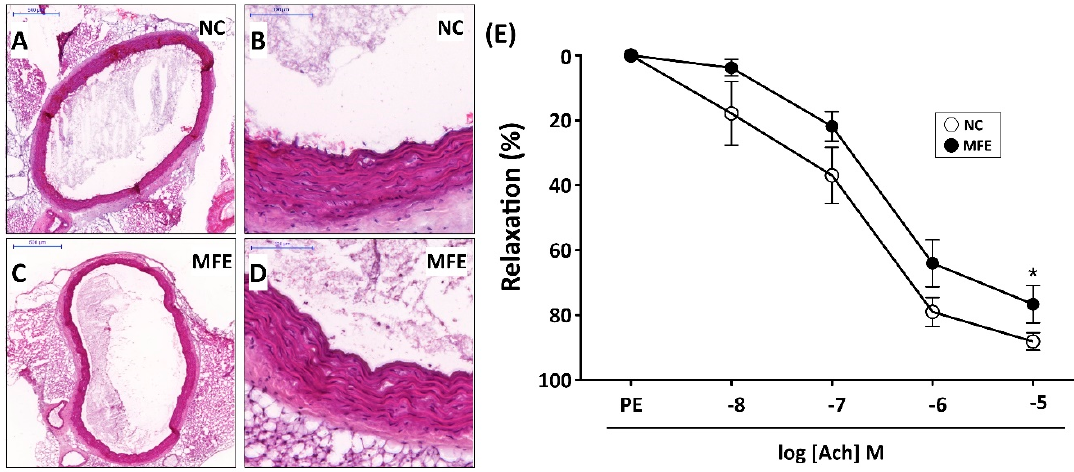
Figure 7. Maternal fructose exposure reduced the endothelium-mediated vasorelaxant response. ( A , B ) Hematoxylin & Eosin (H&E) staining for a cross-section of the aorta in NC offspring. ( C , D ) H&E staining for a cross-section of aorta in MFE offspring. (E) Endothelium-mediated relaxation to acetylcholine was assessed in aortic rings from 3-month-old offspring. Data were calculated as changes from the contraction induced by phenylephrine. NC, normal control; MFE, maternal fructose exposure; Ach, acetylcholine. Scale bar in the upper-left corner of ( A ) and ( C ) indicates 500 μ m. Scale bar in the upper-left corner of ( B ) and ( D ) indicates 100 μ m. Error bars represent the standard deviation (SD). * Indicates statistical significance between NC and MFE group. n = 8 for each group.